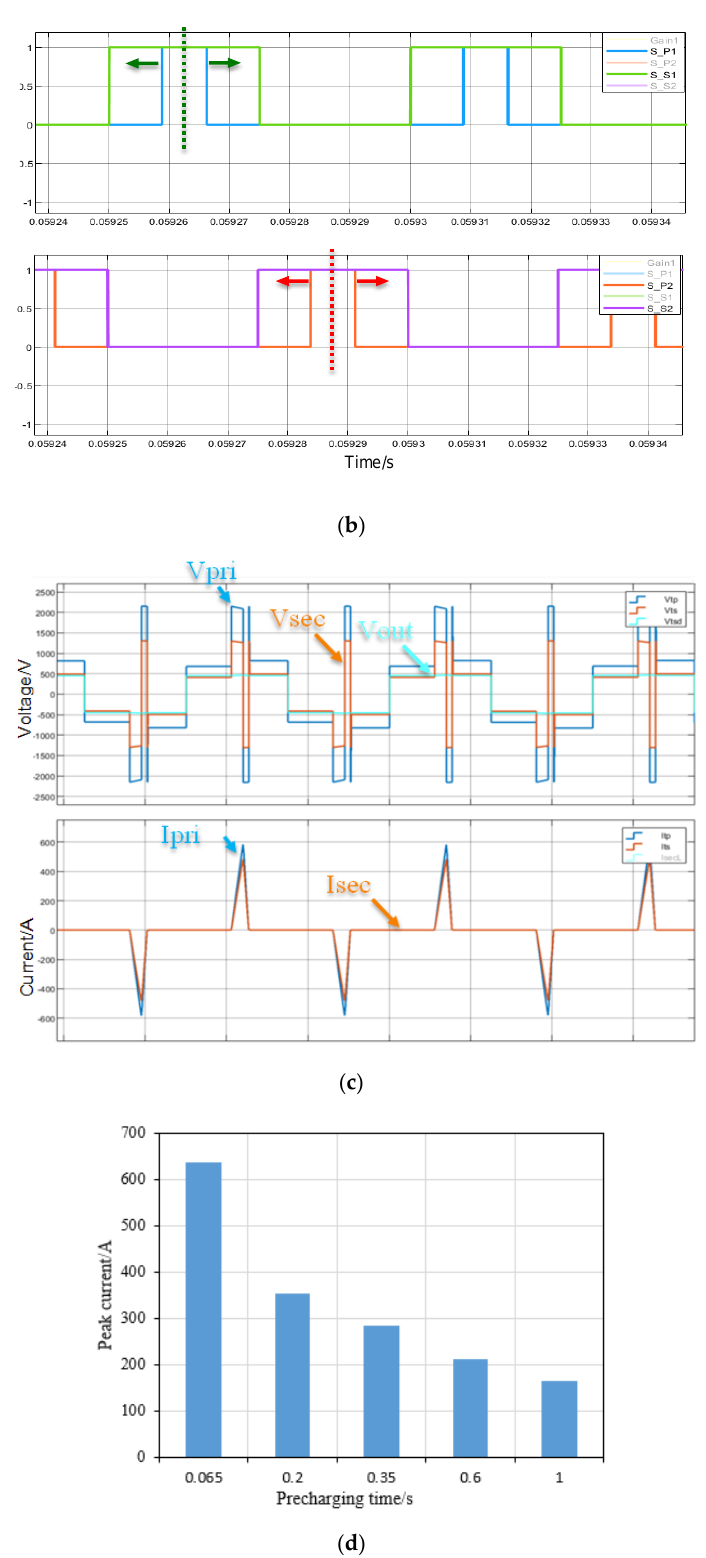
Figure 12. Pre-charging mode of the DCX stage. ( a ) Pre-charging process when the pre-charging time = 1 s; ( b ) Gate signals modulation of the switches; ( c ) Zoom-in waveform of primary and secondary voltage and current; and ( d ) Relationship of the peak current and pre-charging